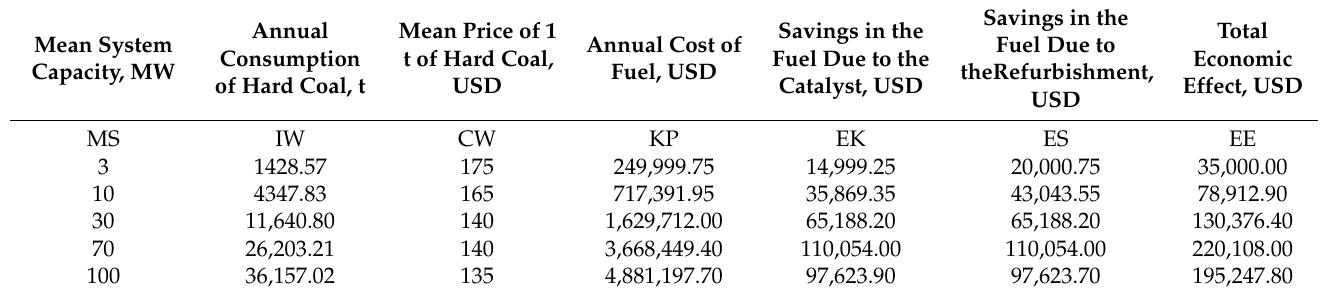
Table 4. The economic effect of the use of the system which improves fuel-combustion efficiency.